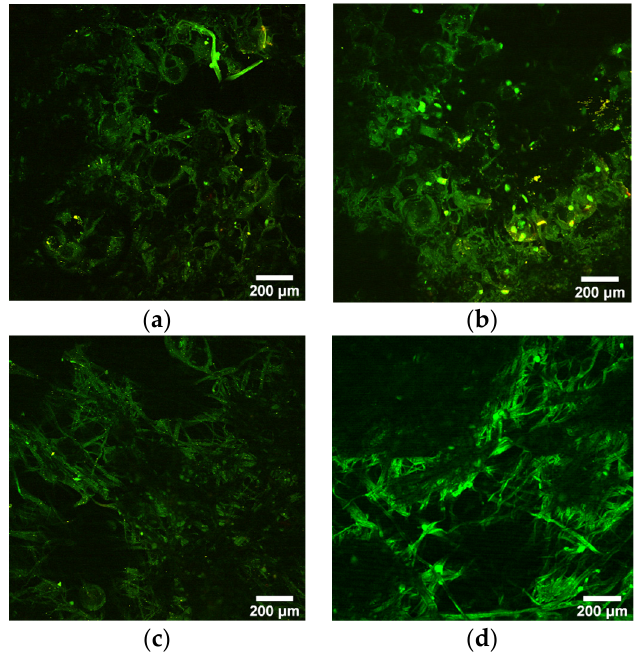
Figure 6. Multiphoton images of 203.75 g/m 2 mat at 24 h ( a ) and 72 h ( b ) and 295.5 g/m 2 mats at 24 h ( c ) and 72 h ( d ) after cell seeding. Samples show low autofluorescence in green.